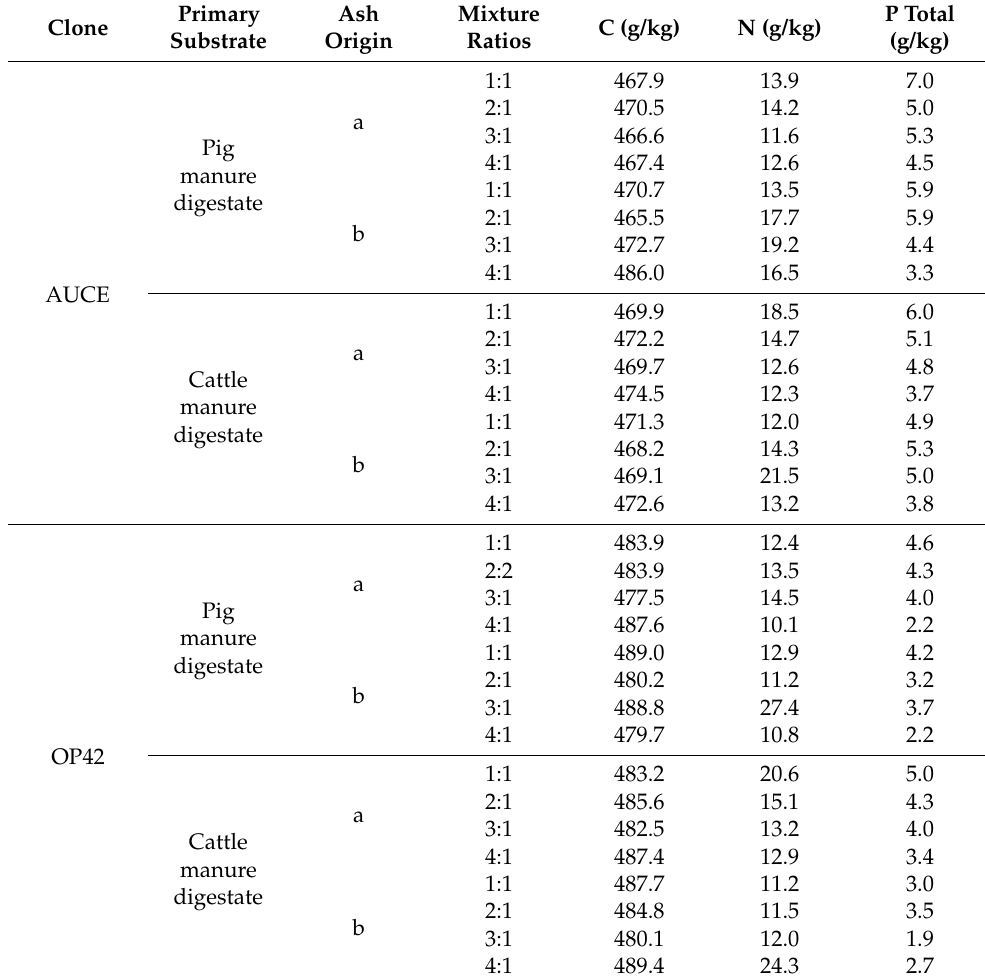
Table A3. Chemical composition of leaves from 26–30 August